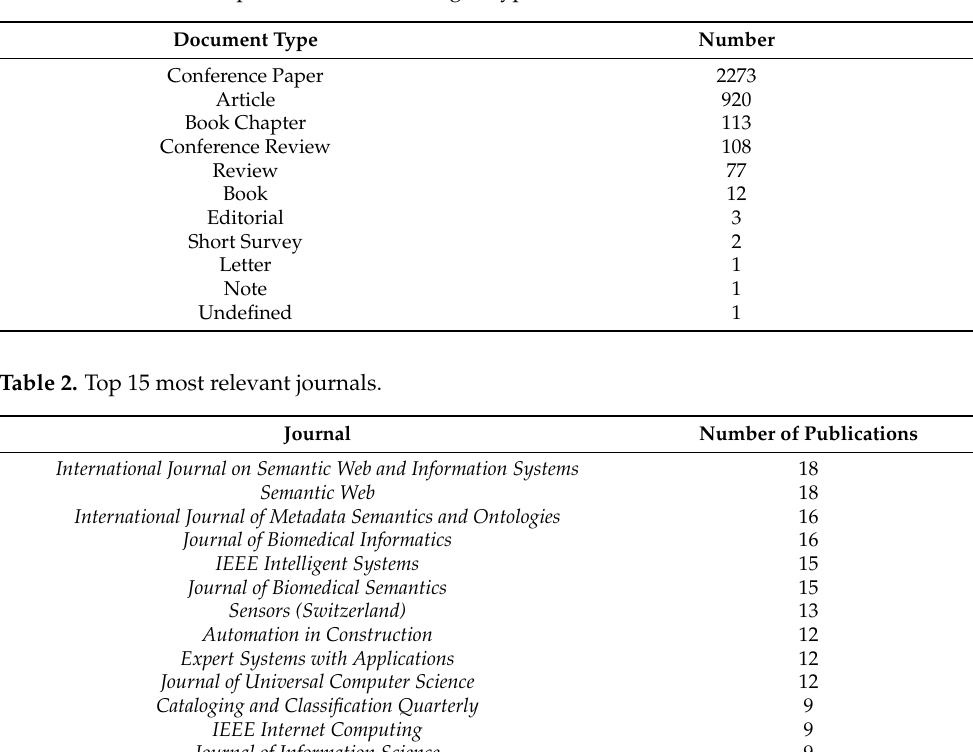
Figure 1. Year-wise distribution of publications using the interoperab* and “semantic web” search. Table 1. Distribution of publications according to type.